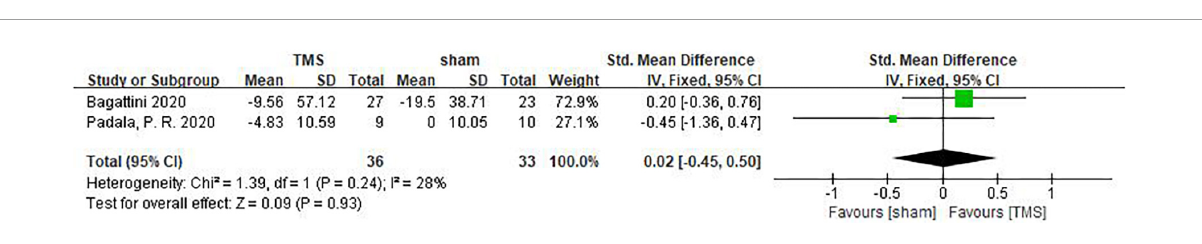
FIGURE11 Forest plot showing the effect of repetitive transcranial magnetic stimulation (rTMS) on TMT-A of AD patients with 95% CI.